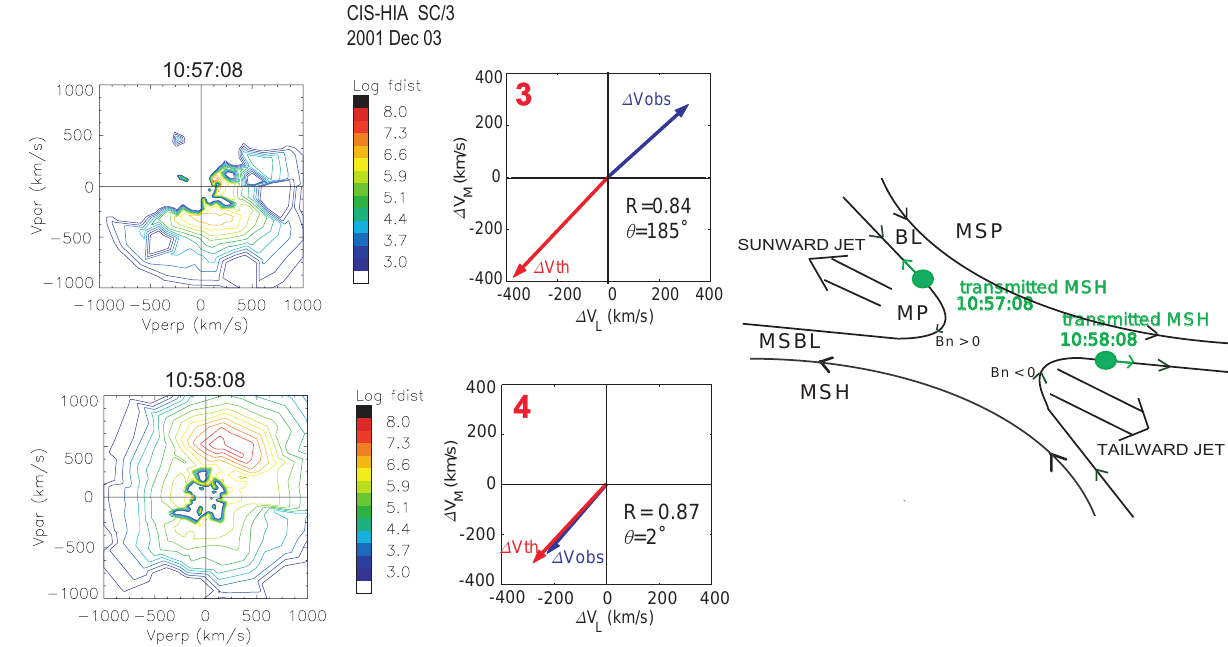
Fig. 4. D-shaped distribution functions on the (V ⊥ ,V k ) plane and Wal´en test on the (L,M) plane for the flow reversal observed by SC/3 between 10:57:08 and 10:58:08 UT. R is the ratio | 1 V obs | / | 1 V th | while θ is the angle between the two vectors 1 V obs and 1 V th on the (L,M) plane. A perfect agreement would result in antisymmetric vectors for the sunward jet ( R = 1 ,θ = 180 ◦ ) and overlapping vectors for the tailward jet ( R = 1 ,θ = 0 ◦ ). The reconnection geometry is sketched on the right.